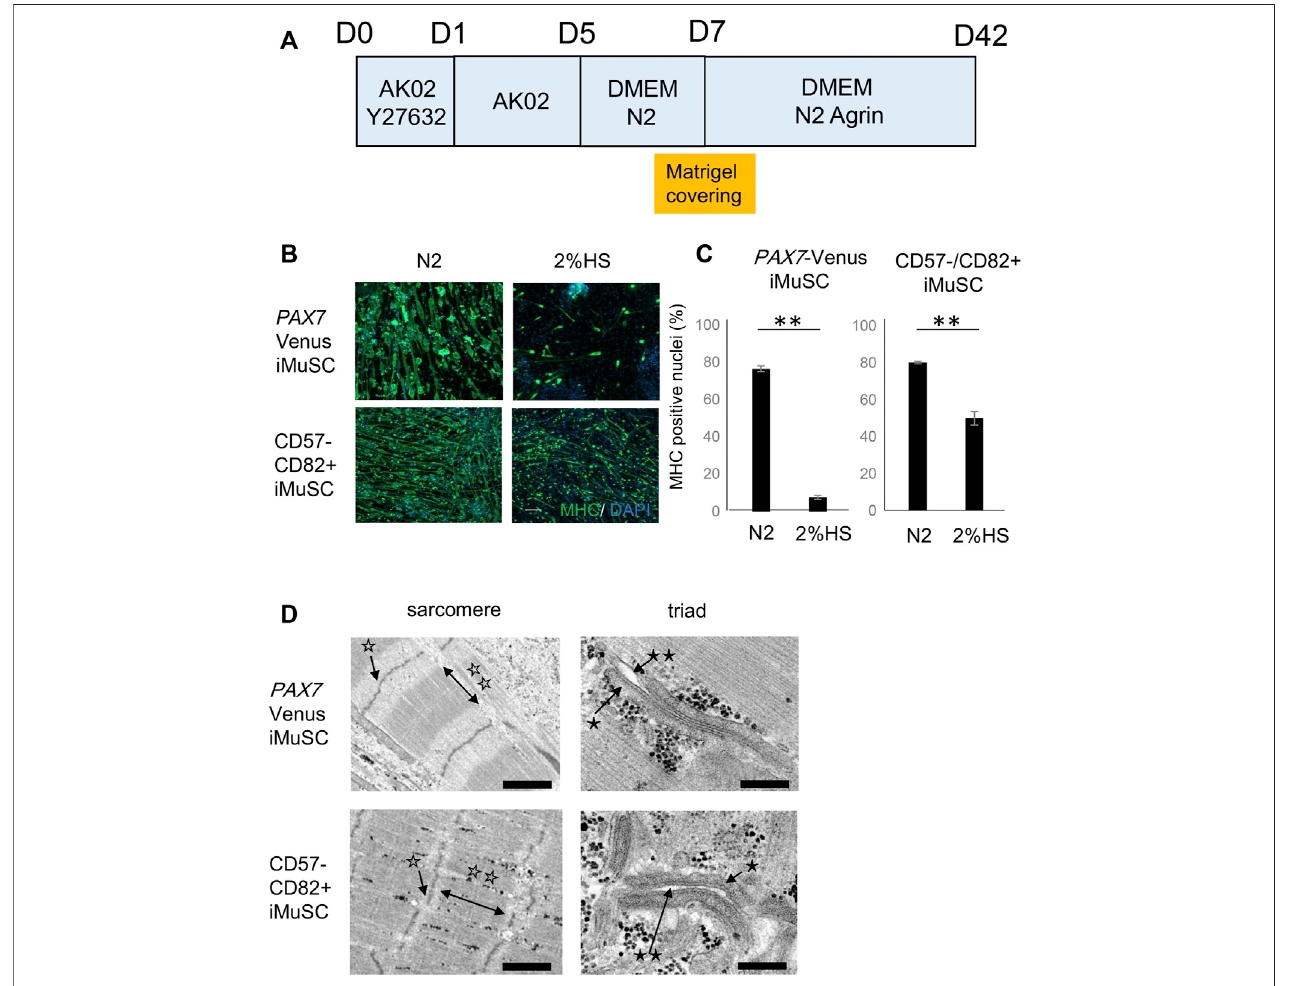
FIGURE1| Generationofmature myotubes fromiMuSCs invitro . (A) Schematicofthemyotubedifferentiation schedule. Theproliferationphase ofiMuSCsisfrom days (D) 0 to 5. D5 is when the medium is switched to the differentiation medium. D7 is when the 3D Matrigel covering is done. (B) Representative images of myotubes (anti-MHC green)in2%HSandN2supplementatD14.Scalebar,1,000 µm. (C) RatioofnucleiofMyHC-positivemyotubestototalnucleiin2%HSandN2supplement at D14. The ratio was higher in the N2 medium compared with that in the HS medium for both Pax7-Venus iMuSC-derived myotubes (left) and CD57 − – CD82 + iMuSC-derived myotubes (right). Data are represented as the mean ± SEM. ** p < 0.01, unpaired two-tailed Student ’ s t-test. (D) Representative electron microscopic images of myotubes in m-condition (Matrigel embedding) at D42. Well-aligned sarcomeric structures and triad structures are seen in Pax7-Venus iMuSC-derived myotubes (upper panel) and CD57 − – CD82 + iMuSC-derived myotubes (lower panel). The white single star ( q ) indicates the Z-line, white double stars ( qq ) indicate the A-line, theblack single star (*)indicates thesarcoplasmicreticulum, and blackdoublestars(**) indicate t-tubules. Scale bars,250 nm (PAX7-Venussarcomere), 200 nm (PAX7-Venus triad), 1,000 nm (CD57 − – CD82 + sarcomere), and 200 nm (CD57 − – CD82 + triad).